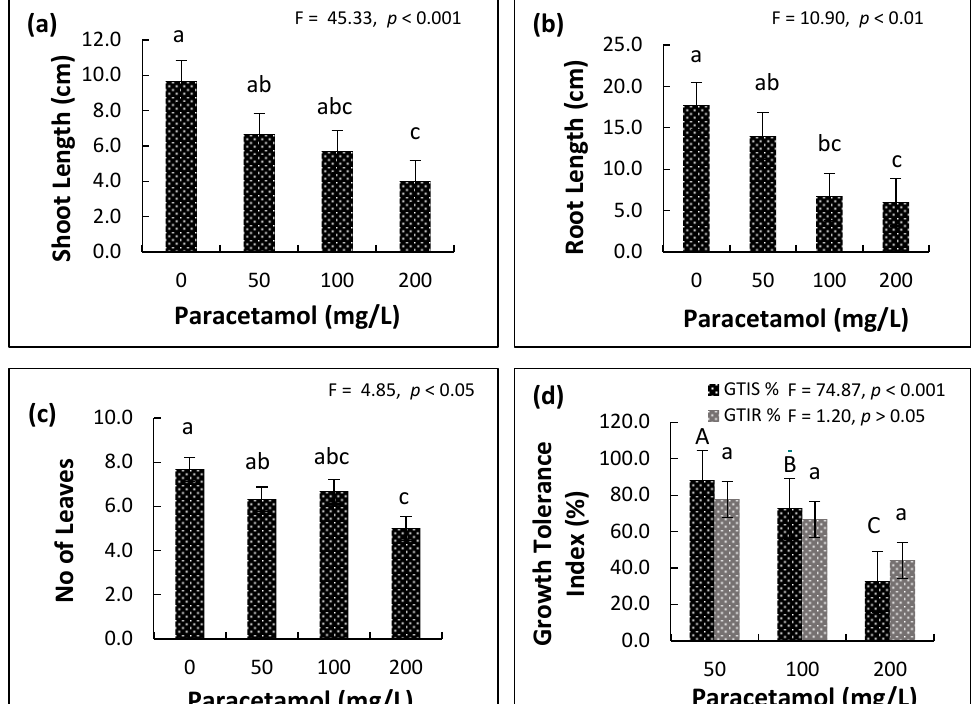
Figure 2. Effects of different paracetamol treatments on spinach ( a ) shoot length, ( b ) root length and ( c ) number of leaves, and ( d ) growth tolerance index (%) of spinach shoots (GTIS) and roots (GTIR) after eight days. Error bars represent means ± S.E. of three biological replicates. For subfigures ( a – c ), means with the different letters are significantly different at p ≤ 0.05. For subfigure ( d ), different upper-case and similar lower-case letters indicate significant differences between GTIS and non- significant differences between GTIR, respectively, at the different paracetamol treatments.